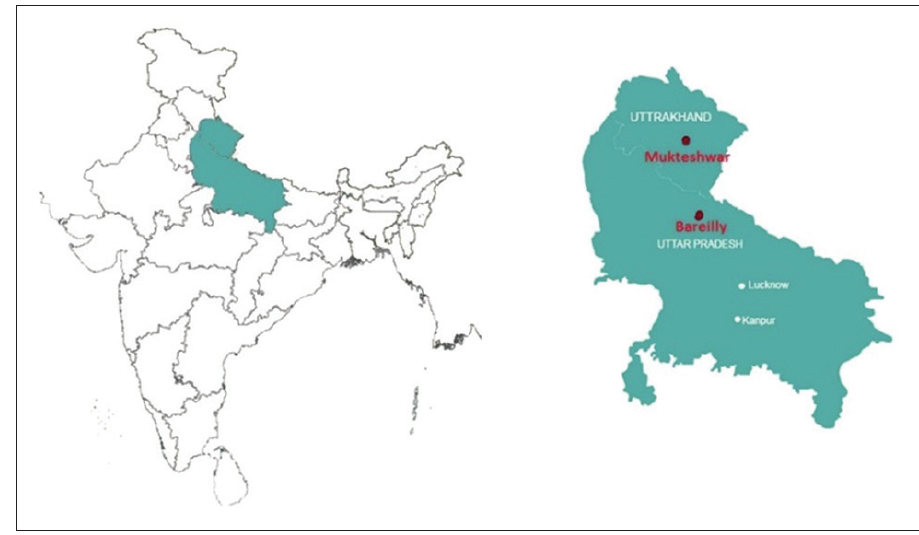
Figure-1: Study area – Bareilly (Uttar Pradesh) and Mukteshwar (Uttarakhand) marked by red